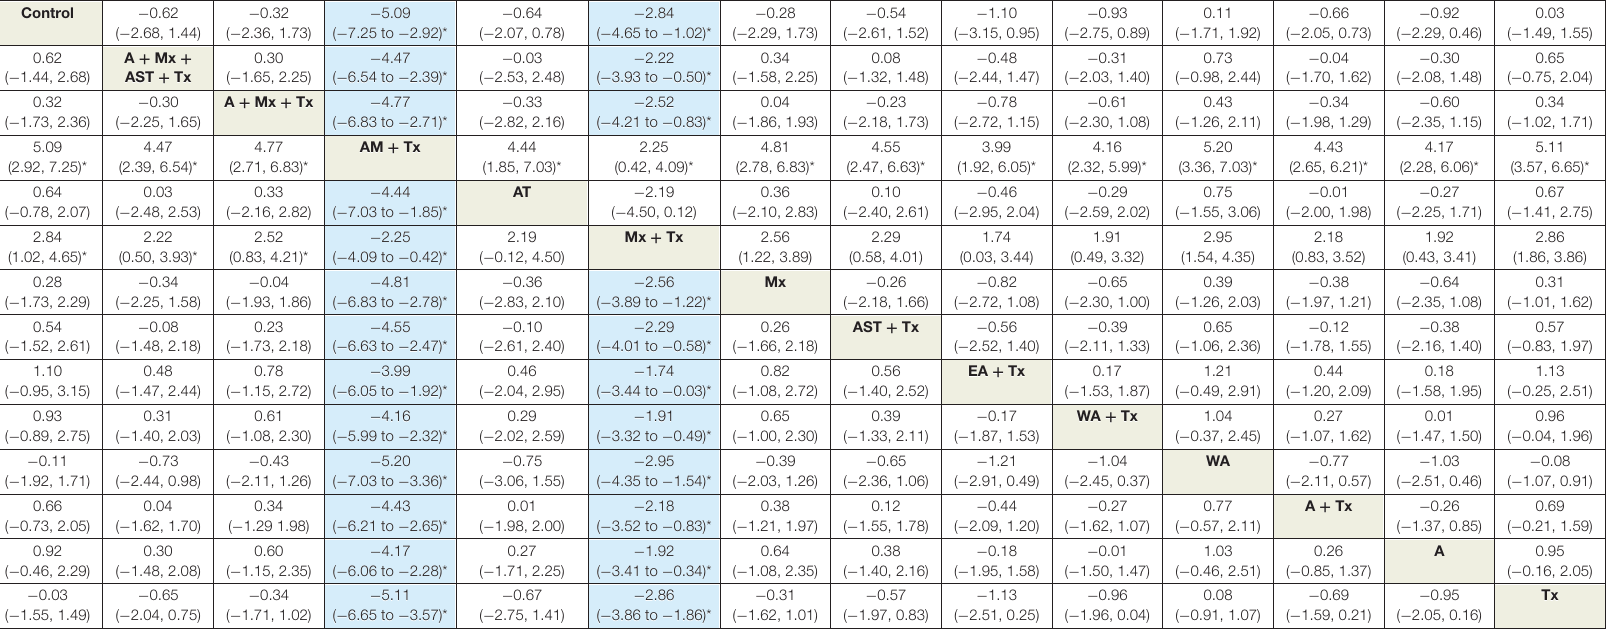
TABLE 3 | Network meta-analysis of health-related quality of life (HRQL).